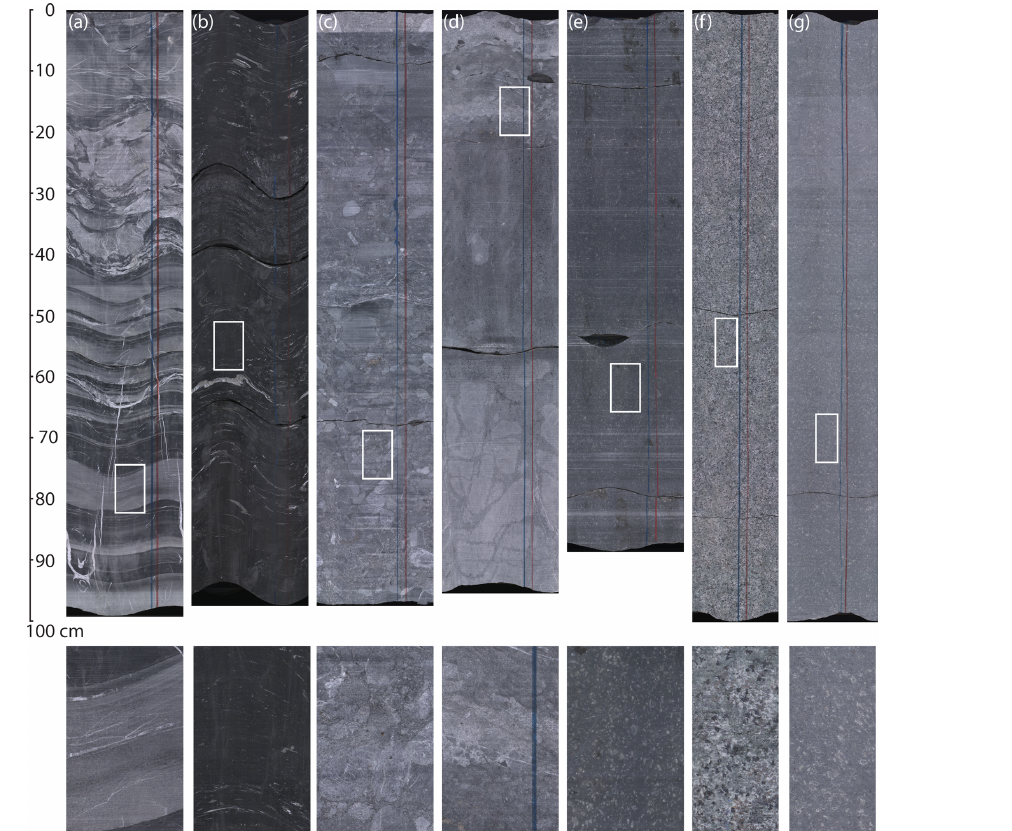
Figure 4. Examples for typical lithologies of the COSC-2 drill core. The upper row shows unrolled core scans of dry core sections (i.e. the entire core surface was scanned and is displayed as a flat image). Visible marks perpendicular to the core are usually caused by the drilling process. The lower row shows enlargements from the unrolled core scans (magnified 4 times when compared to upper row). For the location, see the white box in the corresponding image of the upper row. (a) Turbidites with slumping structures (section 91-3; 352m depth). (b) Sheared Alum Shale (section 254-3; 817m depth). (c) Conglomerate (in the clastic section between Alum Shale and top basement; section 354-3; 1096m depth). (d) The preserved contact between basement (porphyry) and overlying clastic sediments (section 395-2; 1215m depth). (e) Volcanic porphyry as it occurs in the upper part of the basement section (section 436-3; 1304m depth). This interval appears dark due inadvertent variation in the drilling process (polishing of the core surface by the drill bit). (f) One appearance of the rock that composes the dolerite intrusions (section 573-3; 1612m depth). (g) Volcanic porphyry close to TD (section 715-7; 2111m depth).